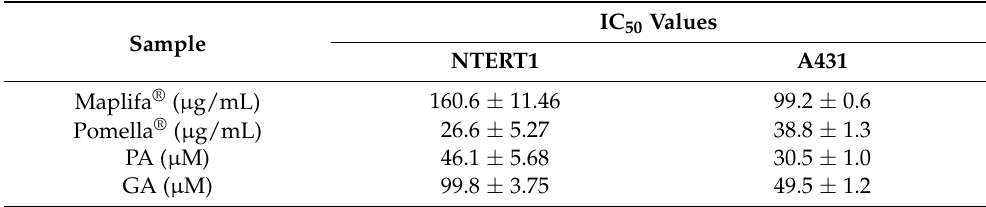
Table 3. The effect of the extracts Maplifa ® and Pomella ® , and their respective major compounds GA and PA in two human skin cell lines NTERT1 and